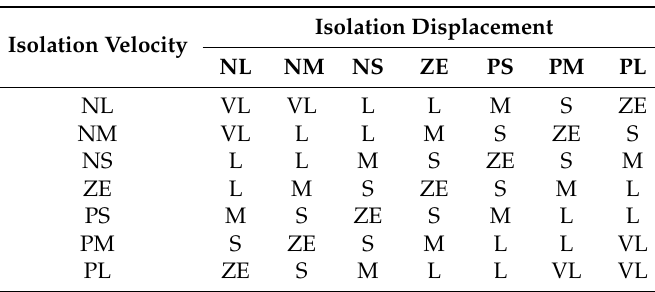
Figure 5. Input and output membership functions for sub ‐ level fuzzy controller: ( a ) input normalized displacement; (b) input normalized velocity; and ( c ) output voltage. Table 3. Fuzzy rule base for sub-level FLC. Table 3. Fuzzy rule base for sub ‐ level FLC.